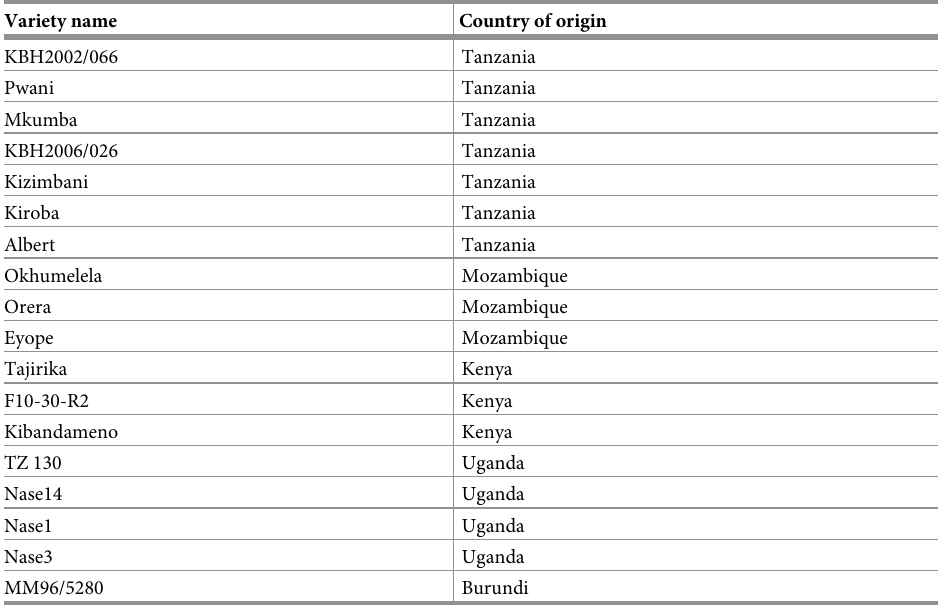
Table 2. Introduced elite germplasm in Burundi and their country of origin. Variety